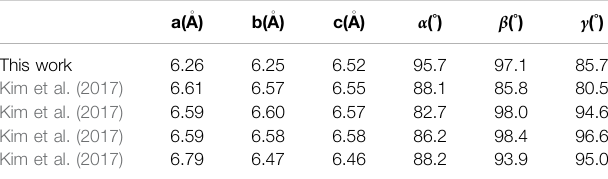
TABLE 1 | Lattice parameters of pseudo-cubic CH 3 NH 2 CH 3 PbI 3 .